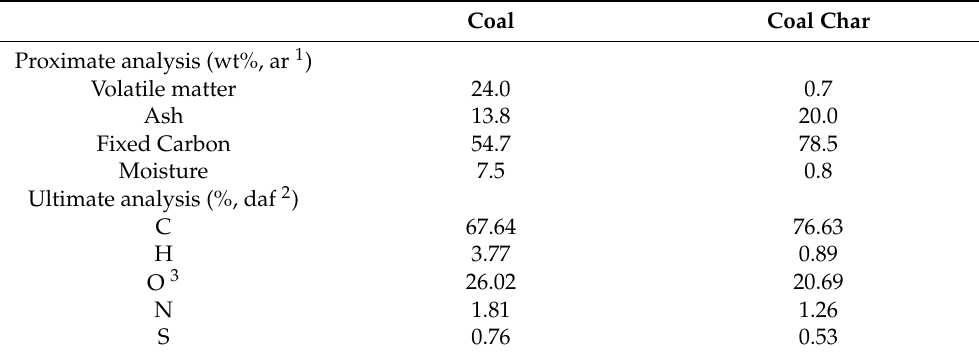
Table 1. Proximate and ultimate analyses of the South African coal considered in the present study and of the coal char produced from the coal particles through pyrolysis experiments in the drop tube furnace.